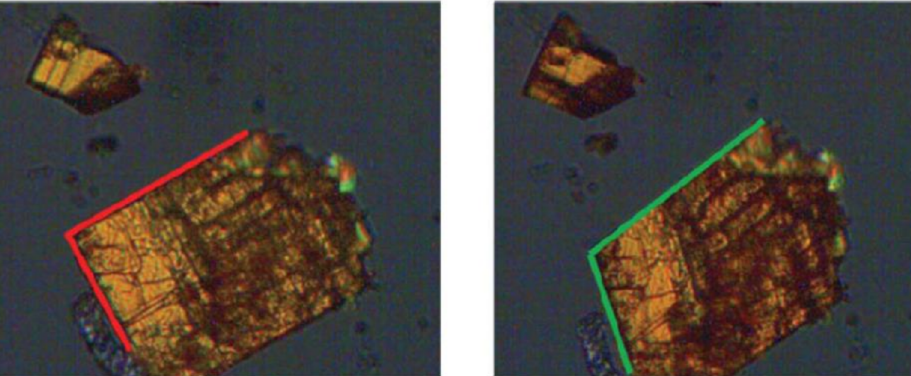
Figure 18. The single crystal to single crystal form β → form α transformation. The red and green lines evidence the change in the monoclinic β -angle from 91 ◦ in Rifaximin form α to 110 ◦ in Rifaximin form β . Reprinted with permission from Ref. [63]. 2019, Royal Society of